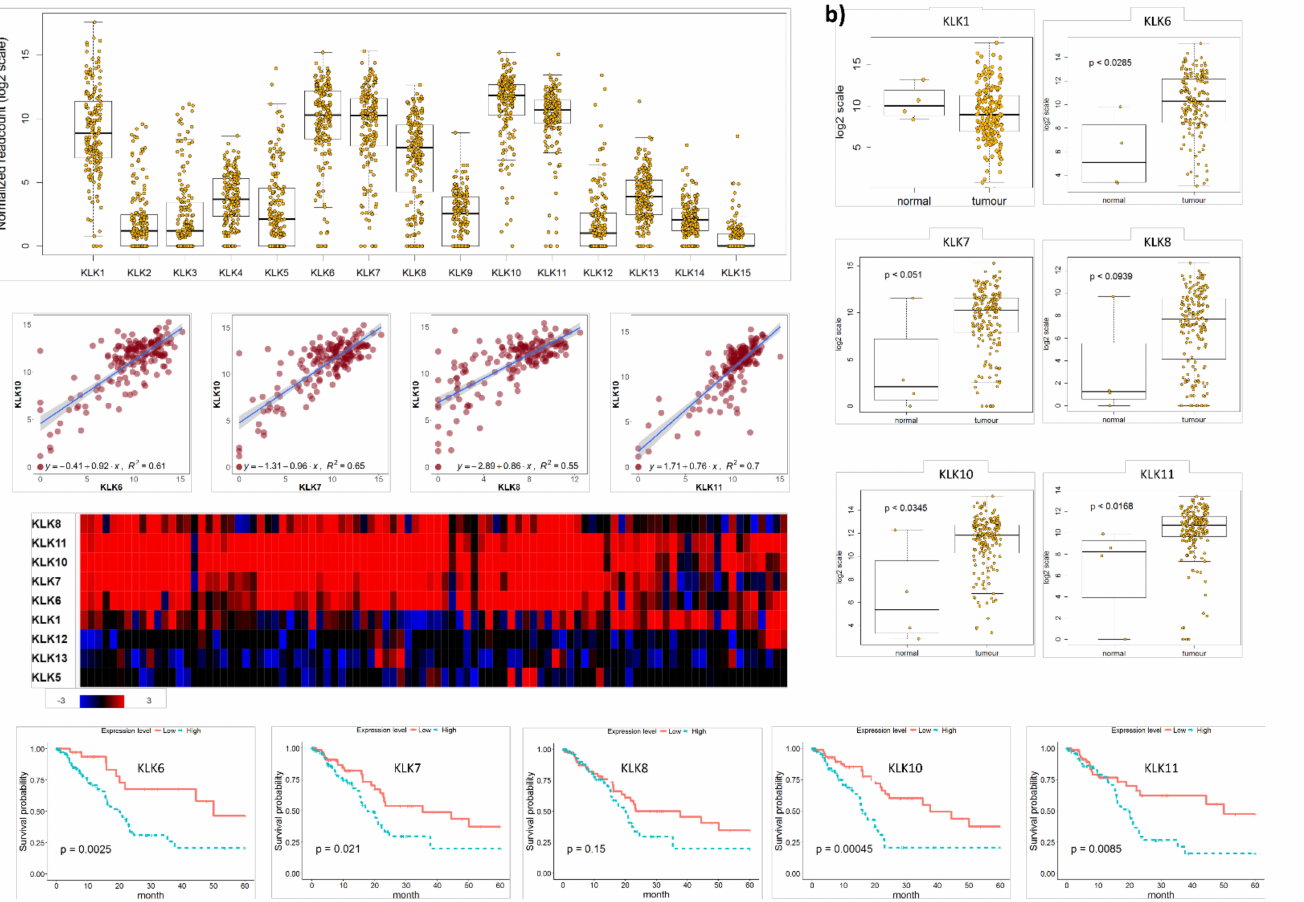
Figure 1. KLK co-expression in PDAC tissues. ( a ) On RNA sequencing, KLK1, KLK6, KLK7, KLK8, KLK10 and KLK11 were identified as highly upregulated in PDAC tissues. Yellow dots represent individual PDAC patients. ( b ) KLK6, KLK7, KLK8, KLK10 and KLK11 were significantly upregulated in PDAC compared to normal pancreas tissues ( p ≤ 0.05), with KLK8 showing a trend ( p = 0.0939). Yellow dots represent individuals. ( c ) Pearson correlation coefficients indicating a significant correlation between KLK10 and KLK6 (R 2 = 0.61), KLK7 (R 2 = 0.65), KLK8 (R 2 = 0.55) and KLK11 (R 2 = 0.7) levels ( p ≤ 0.05). Purple dots represent individual patients. ( d ) On whole-genome sequencing, KLK6, KLK7, KLK8, KLK10 and KLK11 were identified as a highly upregulated gene cluster in PDAC compared to normal pancreas tissues. Rectangles represent individual patients; red—upregulation; blue—downregulation; black—not differentially expressed. ( e ) Kaplan–Meier analysis indicated that high KLK6 ( p = 0.0025), KLK7 ( p = 0.021), KLK10 ( p = 0.00045) and KLK11 ( p = 0.0085) expression levels were significantly associated with a shorter 5-year survival than low expression